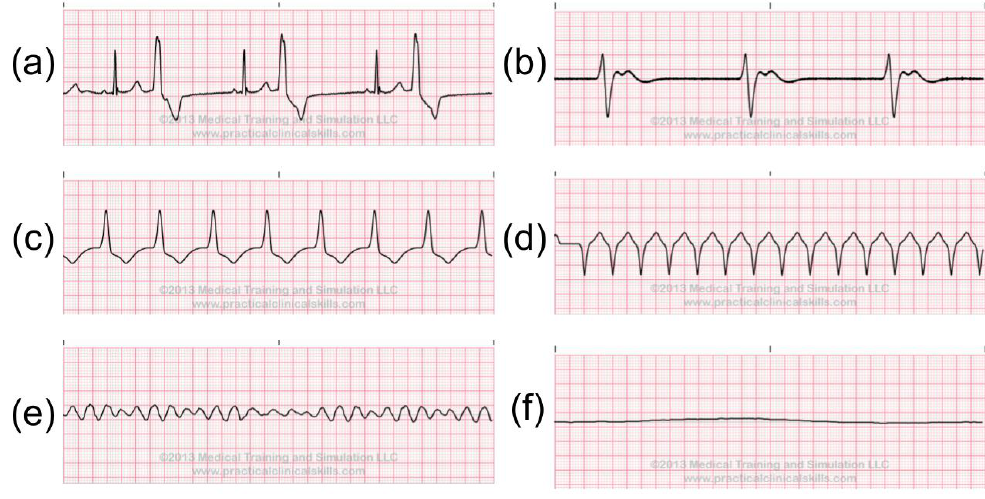
Figure 7. Abnormal Ventricular Rhythms: ( a ) Premature Ventricular Contraction, ( b ) Ventricular Escaped Rhythm, ( c ) Accelerated Idioventricular Rhythm, ( d ) Ventricular Tachycardia, ( e ) Ventricular Fibrillation, ( f ) Ventricular Asystole